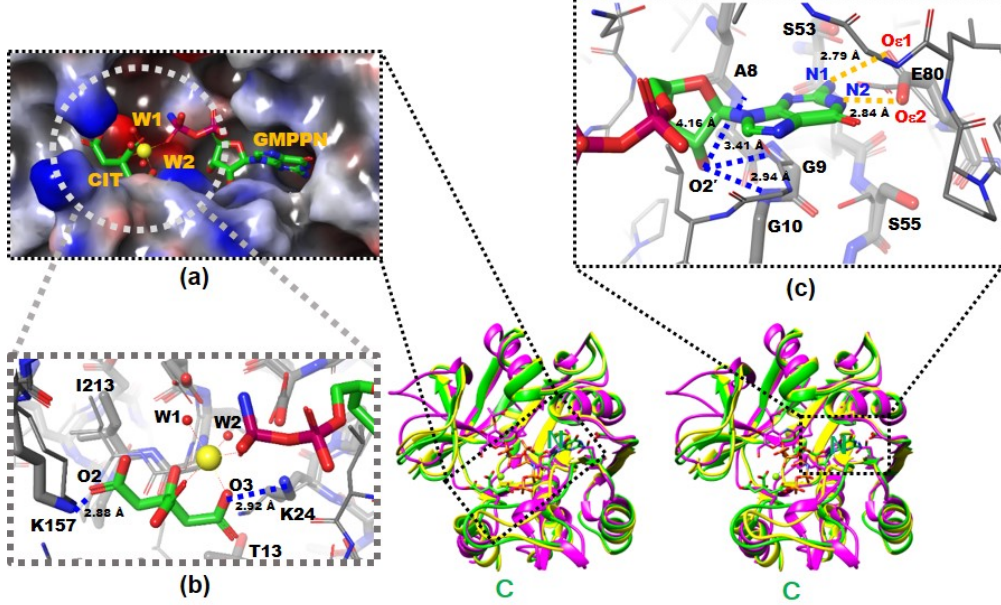
Figure 1. The X-ray crystal structures of native and complexed Yp HddC. A stereodiagram of superimposed X-ray crystal structures of Yp HddC complexed with guanosine 5 (cid:48) -( β -amino)-diphosphate (GMPPN) ( Green crystal structure ), native Yp HddC ( Yellow crystal structure ) and MurU ( N -Acetylmuramic acid α -1-phosphate (Mur N Ac- α 1-P) uridylyltransferase, pink crystal structure ) from Pseudomonas putida ( Pp MurU) has been drawn. The average RMS deviation of 218 C α atom pairs between native Yp HddC and its GMPPN bound form is 0.477 Å. Those of pruned C α atom pairs of MurU are 1.082 Å and 1.047 Å with native (123 C α atoms) and complexed (122 C α atoms) Yp HddC, respectively. The N - and C-terminal are labeled. ( a ) The electrostatic surface potential of the catalytic site of Yp HddC. The molecular surface was drawn ( Red , negative charge ; Blue , positive charge ; White , uncharged ) by the Schrödinger software package [11]. The bound GMPPN, Mg 2 + , one citrate and two water molecules are depicted with a ball-and-stick model. The six coordinates of the magnesium ion are represented by dotted lines; ( b ) the enlarged view centered on the magnesium ion ( Yellow sphere ). The native (Thin) and the GMPPN complex (Thick) structures were drawn with a ball-and-stick model. The oxygen atoms of the citrate molecule interacting with Lys24 and Lys157 are labeled. Thr13 and Ile213 interact with the citrate are also labeled. However, Leu15 is not visible in this view; ( c ) the comparison of the nucleotide-binding pockets of Yp HddC. The large induced-fit conformational change is observed in around the GXGXR motif of the GMPPN bound form (The thick model). The A8, G9, and G10 form an oxyanion hole-like conformation and interact with O2 (cid:48) oxygen atom of GMPPN as indicated with the blue dotted lines. That change again triggers the rotation of the side chain of Ser55. The two oxygen atoms of Glu80 which form hydrogen bonds (The gold dot lines) with the two nitrogen atoms of the guanine base of GMPPN are also